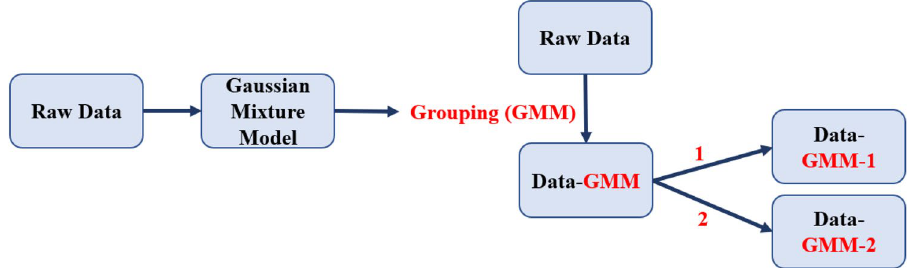
Figure 6. Workflow for the Gaussian mixture model (GMM) ComBat implementations. Red denotes a batch effect, while the dash indicates that the data has been harmonized by a particular batch effect (i.e., Data-1 indicates that the data has been harmonized by batch effect 1).